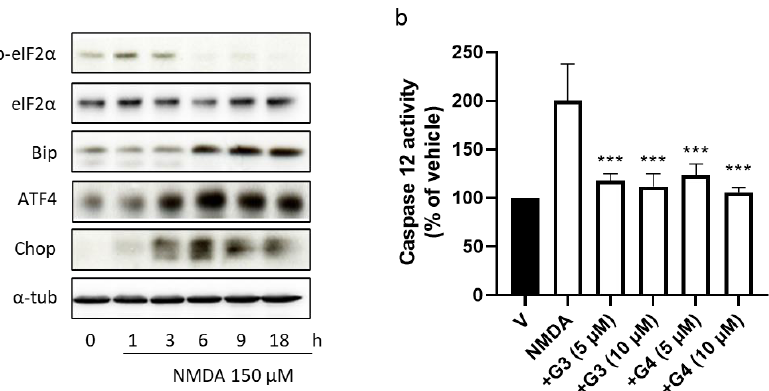
Figure 5. Effect of phosphorous dendrimers on NMDA-induced changes in ER-stress-signaling proteins and in caspase 12 activity. ( a ) Neurons were treated with vehicle (V) or the indicated concentration of G3 or G4 phosphorous dendrimers for 1 h. Then, NMDA (150 µM) was added and the incubation continued for another 1 h for p-eiF2α and eiF2α determination and for 6 h for Bip, ATF4, and Chop protein determination by Western blot, as described in the Materials and Methods section. α-Tubulin was used as loading control. The image shows one representative experiment that was repeated three times with similar results. ( b ) Neurons were treated with vehicle (V) or the indicated concentration of phosphorous dendrimers for 1 h. Then, NMDA (150 µM) was added and after 6 h, caspase 12 activity measured as indicated in the Methods section. The data represent the mean + the s.e.m. of three experiments. *** p < 0.001 as compared to NMDA-treated cells in the absence of dendrimers.